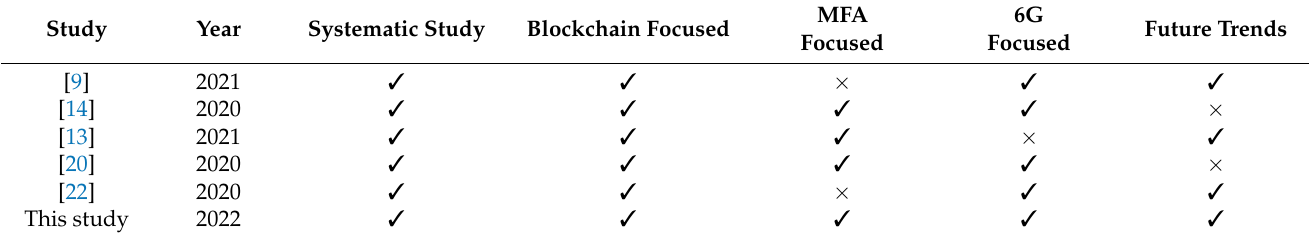
Table 1. Comparison with other similar review articles ( (cid:51) : Yes, × :